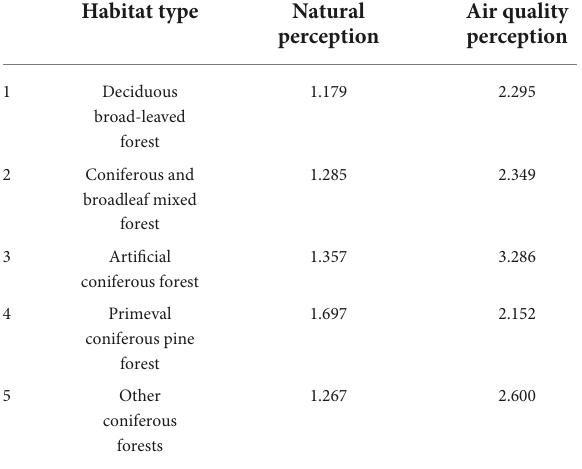
TABLE 2 Differences in nature perception and air quality perception in different habitat types.